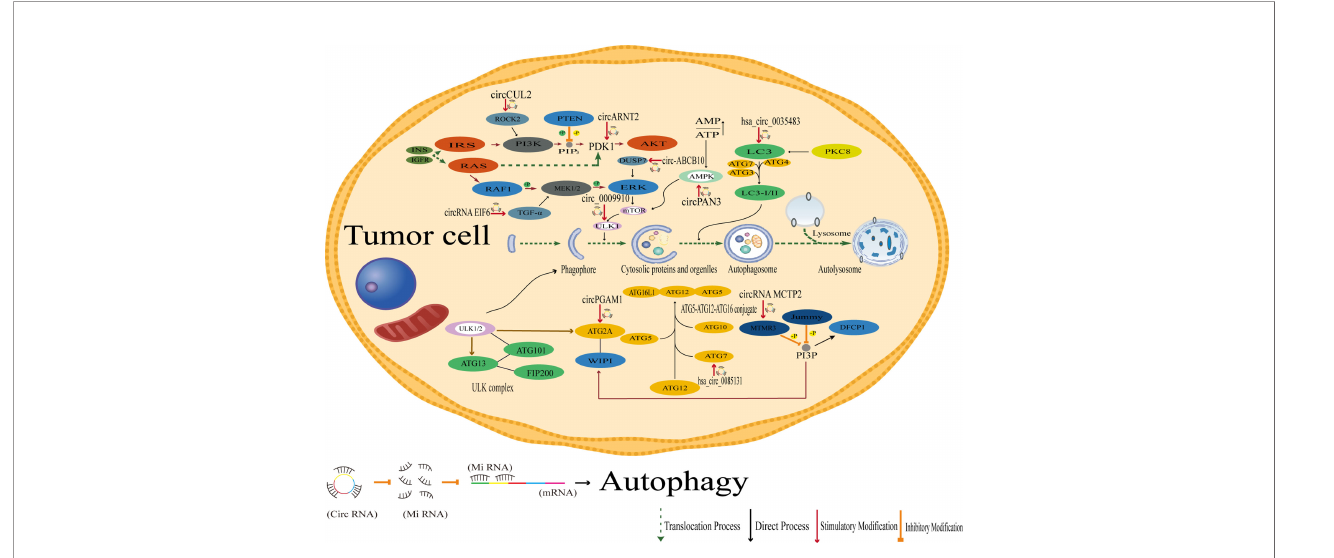
FIGURE 5 | CircRNA regulate autophagy-mediated